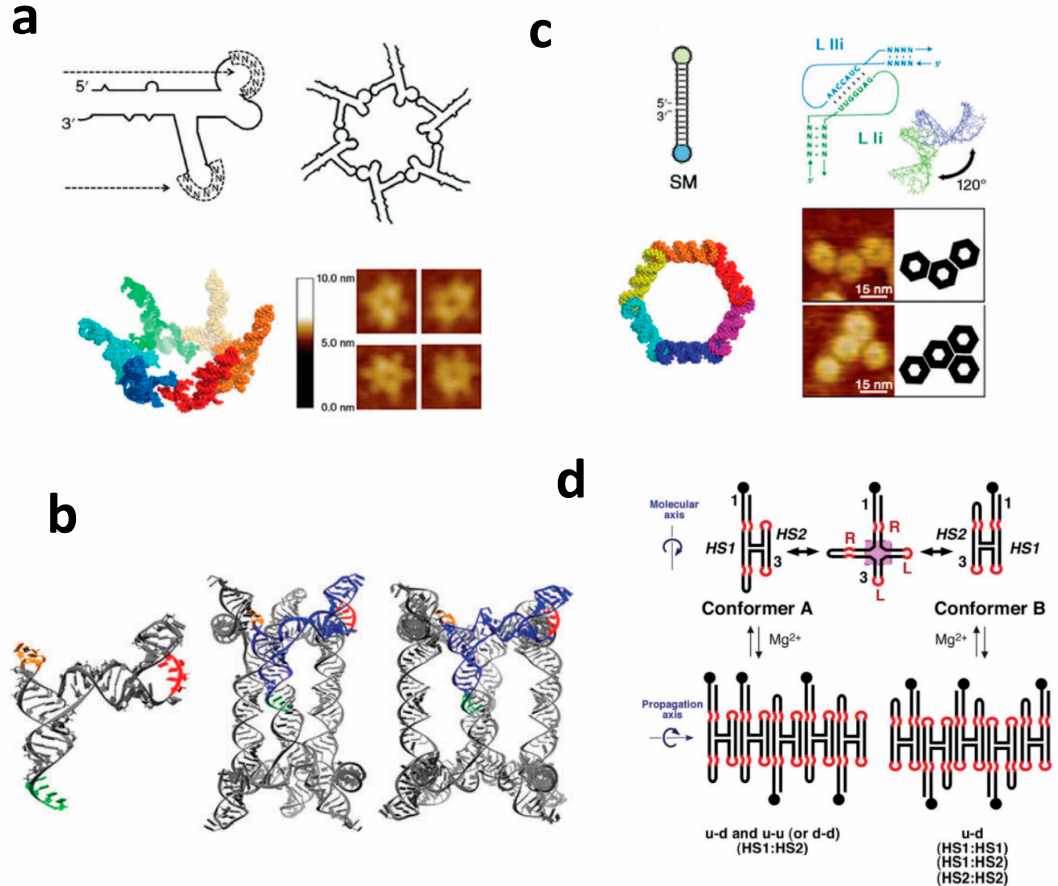
Figure 3. RNA nanostructures assembled from loop–loop and receptor–loop interactions. ( a ) Examples of pRNA assembly into hexamers and ( b ) RNA nanocages facilitated by pRNA loop–loop interactions. ( c ) Nanoring structures obtained by using advantage of 120 ◦ angle formed by kissing–loop interactions between RNAI and RNAII loop sequences of ColE1. ( d ) Examples of RNA filaments self-assembled via intermolecular receptor-loop loop-receptor interactons. Figure 3a–d were adapted with permissions from Ref [54] (Copyright 2013 RNA Society), Ref [55] (Copyright 2014 Springer Nature), Ref [18] (Copyright 2011 American Chemical Society), and [57] (Copyright 2006 Oxford University Press), respectively.